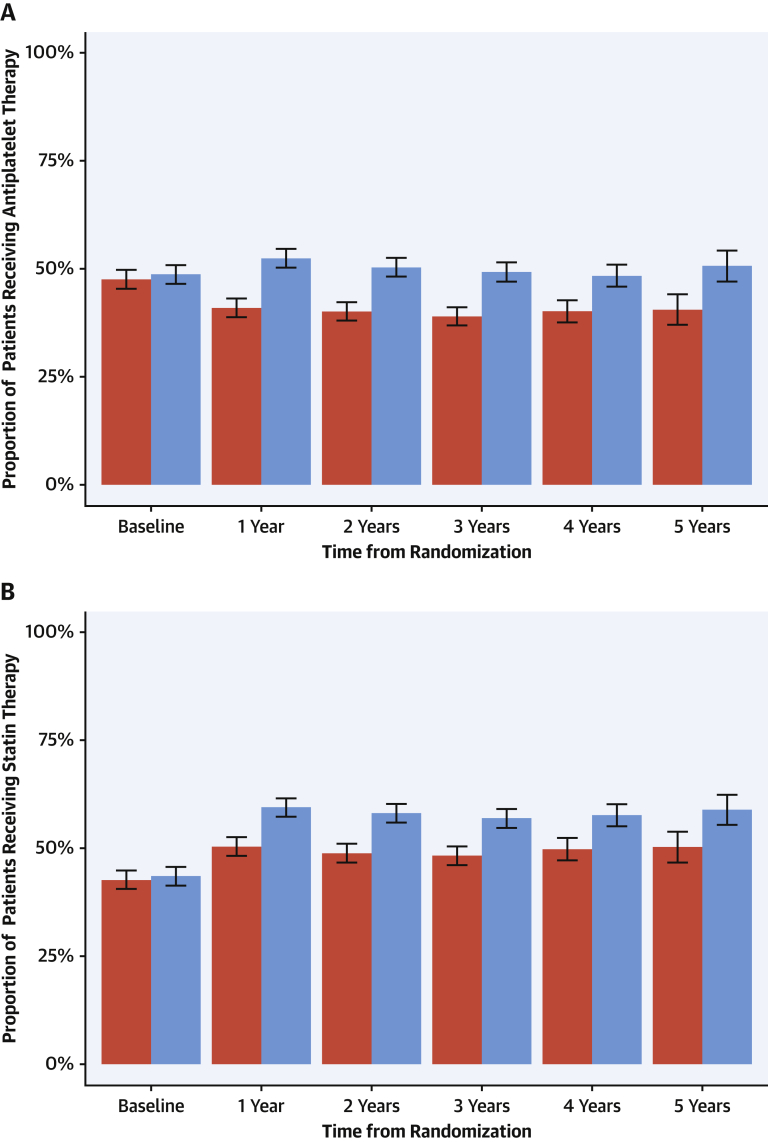
Prescribing of Preventative Therapy Over 5 Years of Follow-UpFrequency of prescribing for (A) antiplatelet and (B) statin therapy across 5 years in patients allocated to standard care alone (red) and computed tomography coronary angiography plus standard of care (blue). The error bars relate to confidence intervals for comparison between trial arms. p < 0.001 for all comparisons except baseline where p = NS.